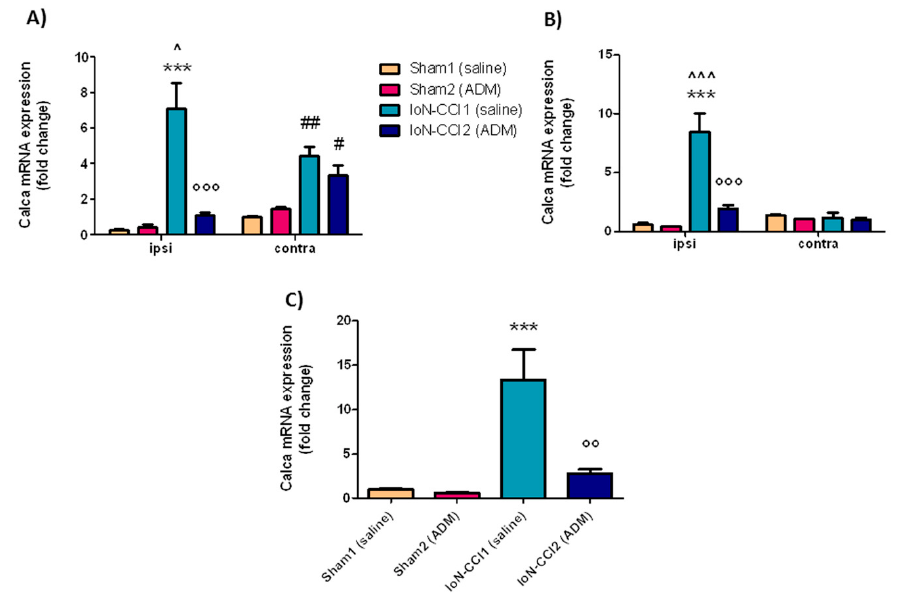
Figure 4. Calca mRNA expression in TGs ( A ), CSC ( B ), and medulla ( C ). Data is expressed as mean